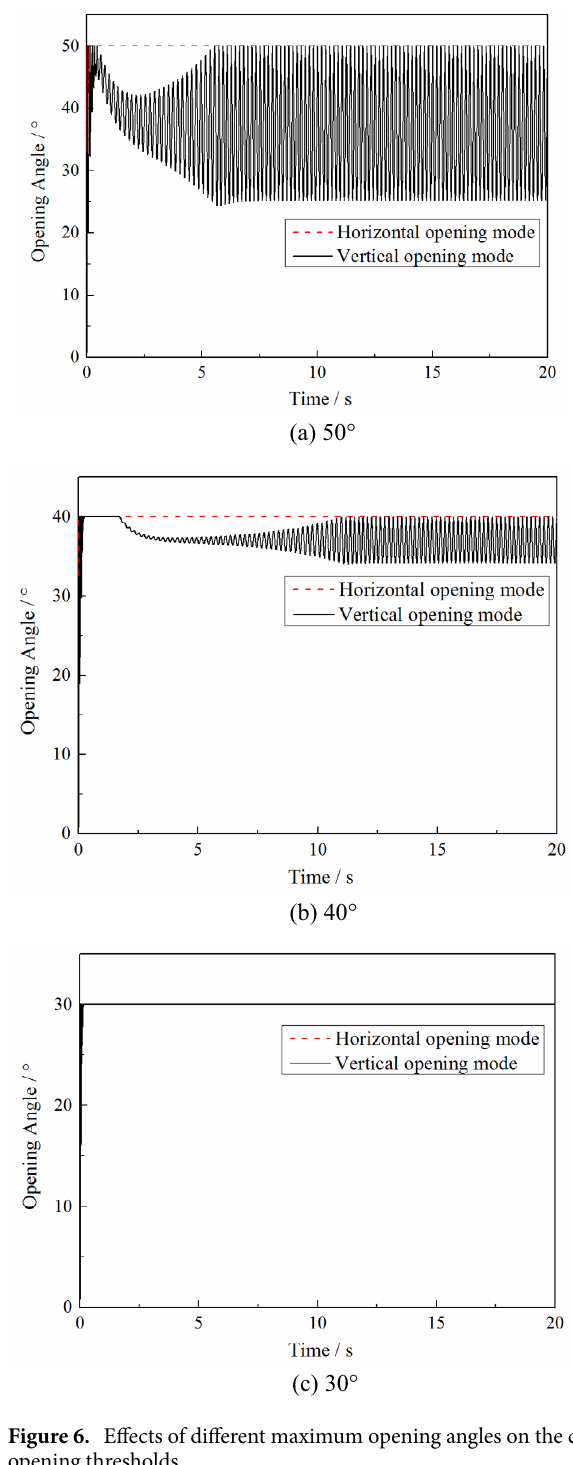
Figure 6. Effects of different maximum opening angles on the changes of the opening angle under different opening